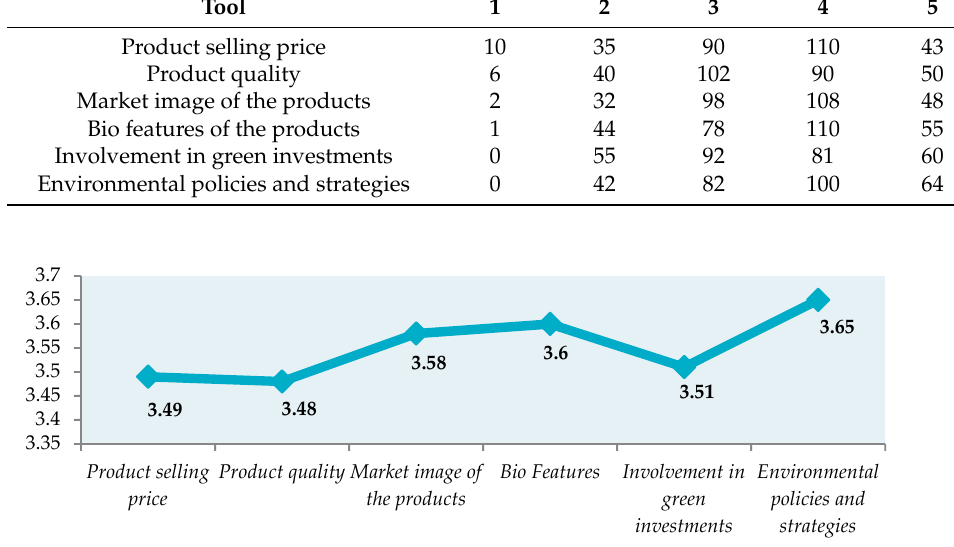
Figure 3. The characteristics of the economic entity analyzed in comparison with the main compet- itors.